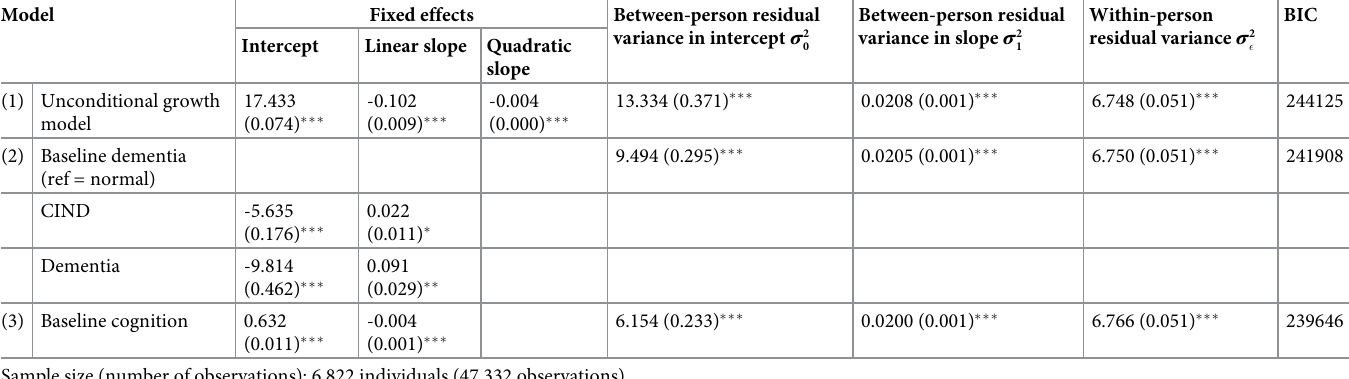
Table 3. Parameter estimates from multilevel linear growth models of cognitive functioning trajectory on baseline cognition score and dementia status, health retirement study, 1998–2016.